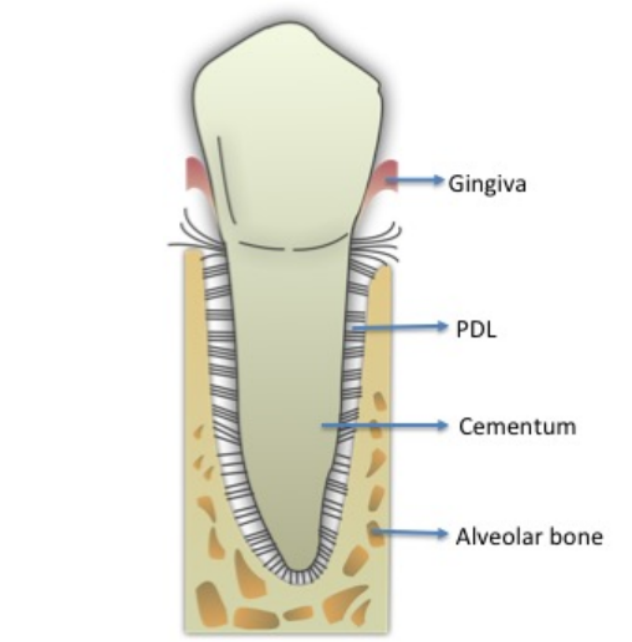
Figure 1. Periodontium with its components: gingiva, periodontal fibers (PDL) and cementum around the tooth root, alveolar bone supporting the